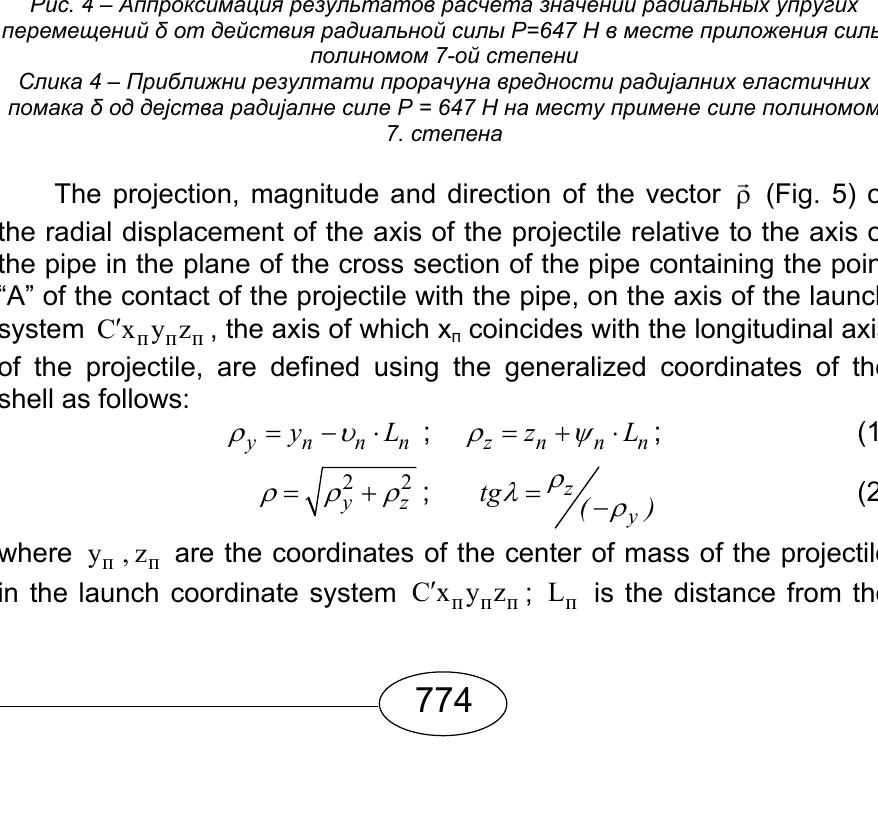
Figure 4 – Approximation of the results of calculating the values of radial elastic displacements δ from the action of the radial force P = 647 N in the place of application of the force by a polynomial of the 7th